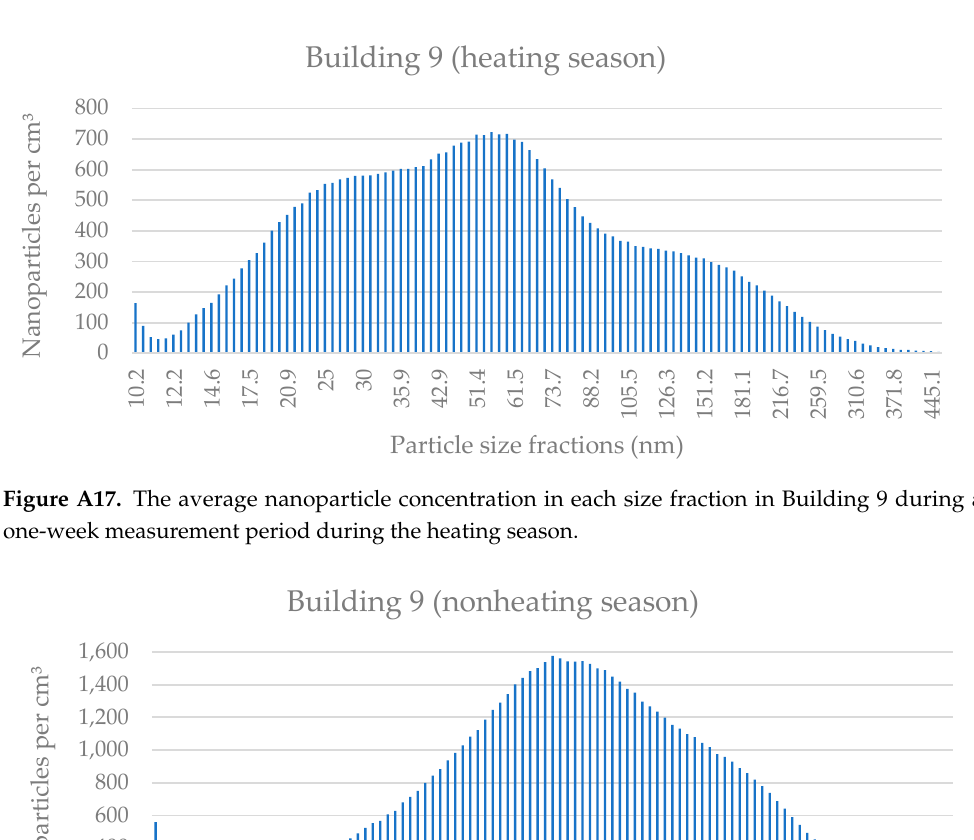
Figure A16. The average nanoparticle concentration in each size fraction in Building 8 during a one- week measurement period during the nonheating season.